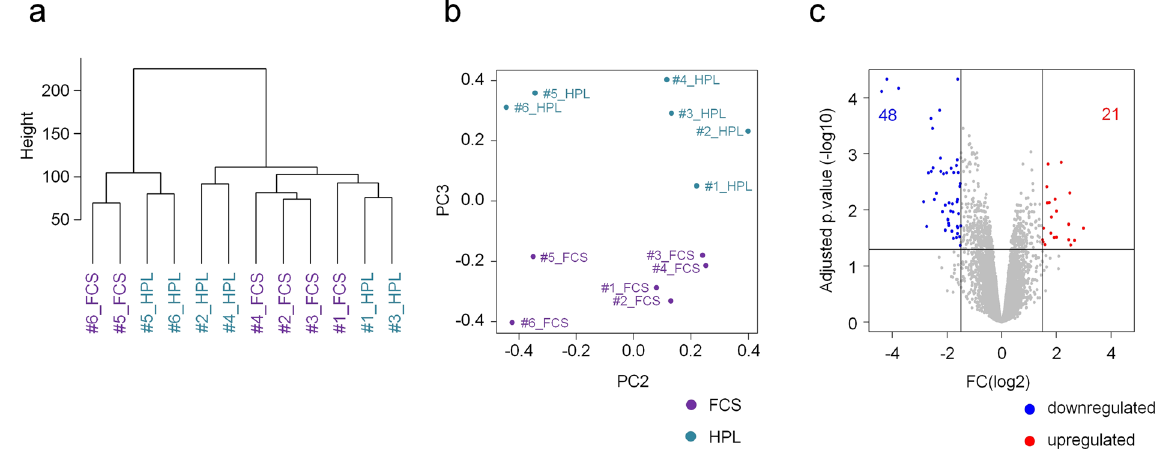
Figure 3. Differential gene expression of MSCs in HPL and FCS. ( a ) Hierarchical clustering of gene expression profiles (Affymetrix Human Transcriptome Array 2.0) does not separate cell preparations from different donors (n = 6), but rather by culture conditions. ( b ) Principal component analysis separates HPL-MSCs and FCS-MSCs, particularly in PC3. ( c ) Volcano plot of differential gene expression (fold change > 1.5 and limma- adjusted P-value of < 0.05). The number of differentially regulated transcripts is indicated (Supplementary Table